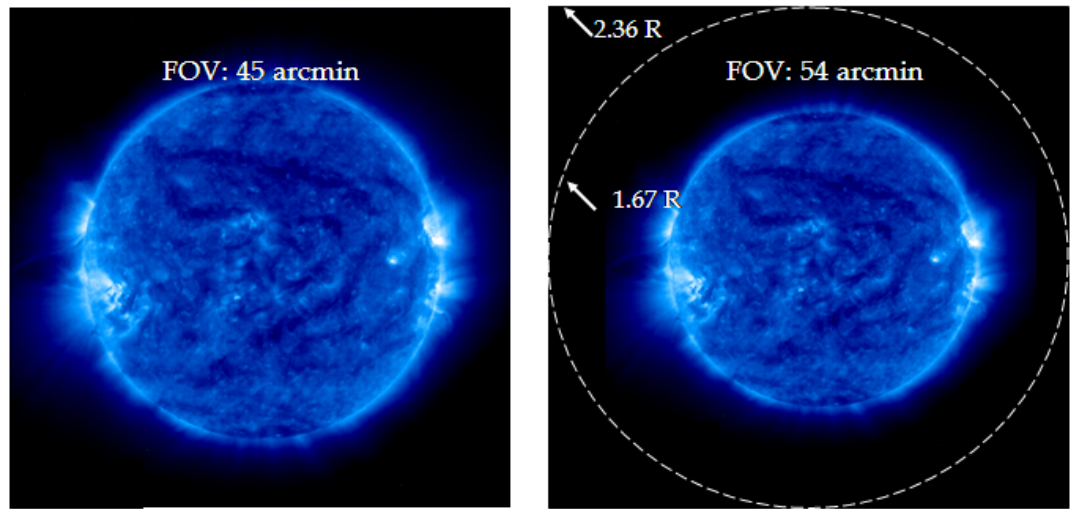
Fig. 2. Demonstration of the SWAP field of view. On the left, a SOHO/EIT image (17.1nm, 8 July 2004, 19:00 UT). On the right, the same image, but rescaled to the SWAP field of